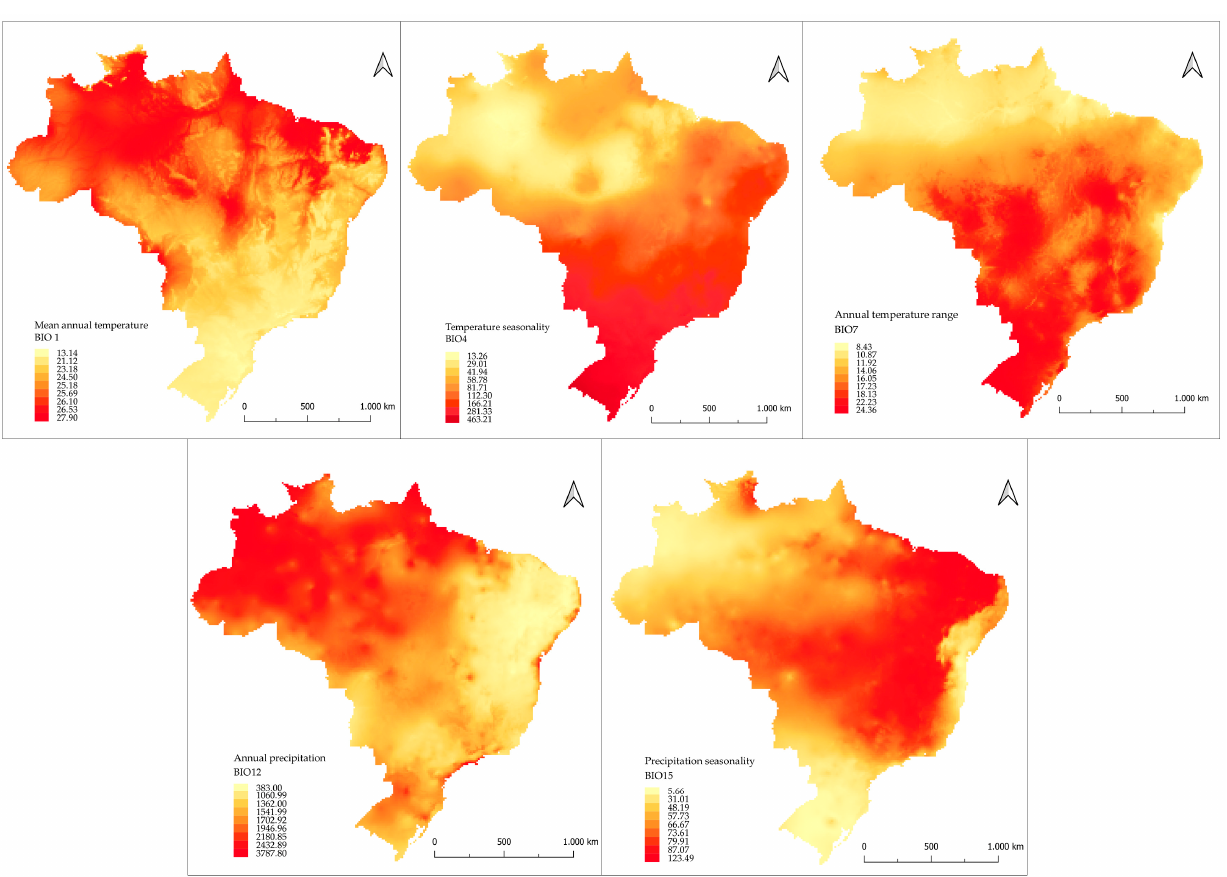
Figure A1. Distribution of climate variables used in modeling the climate suitability of COVID-19 cases in Brazil.